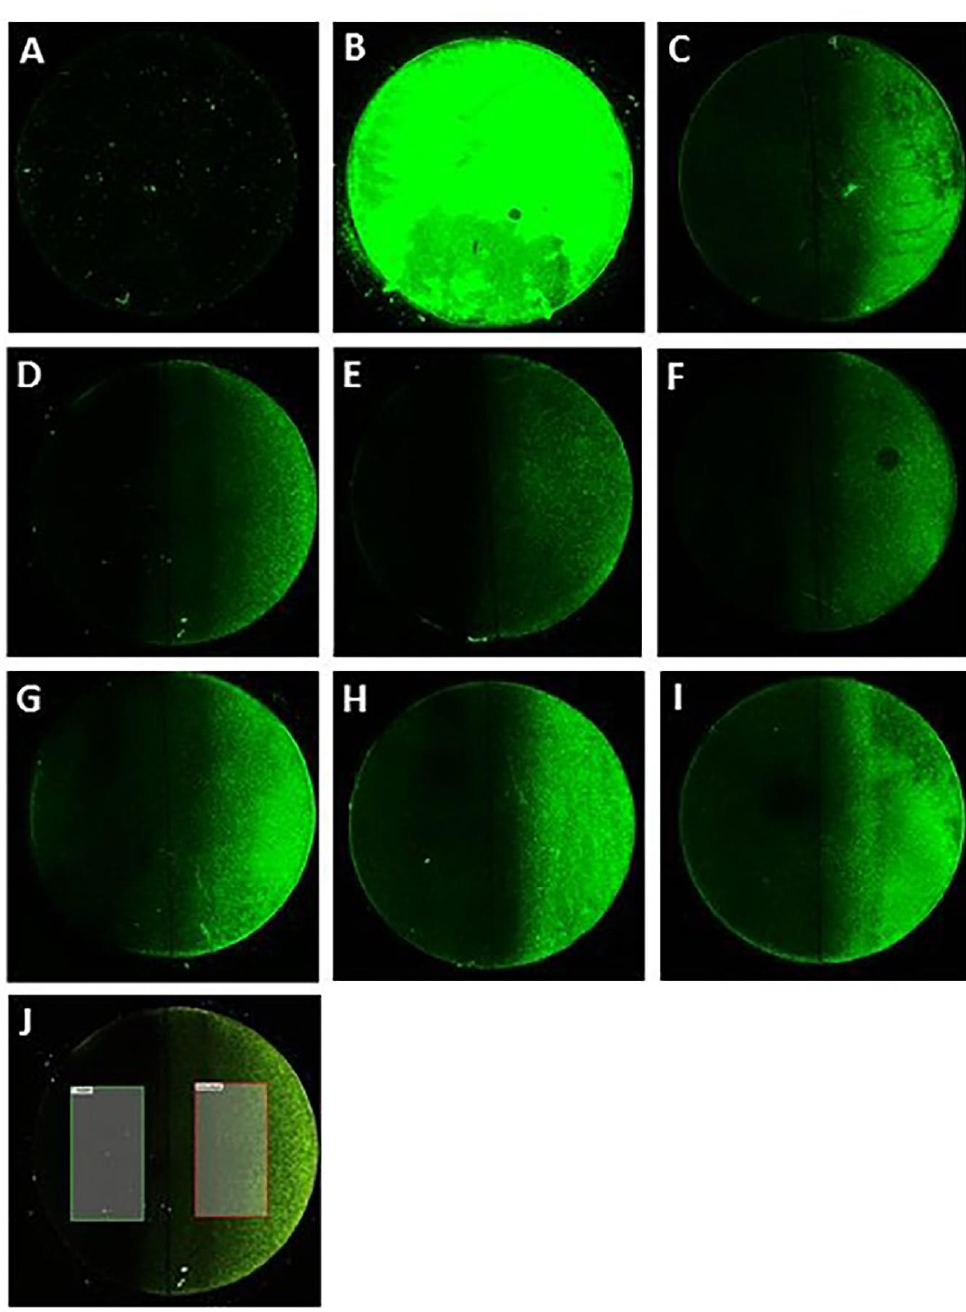
Figure 6. Autofluorescence of bacterial biofilm on MRS discs before and after treatment with air abrasive unit delivering different powders: ( A ) pristine disc; ( B ) contaminated untreated disc; ( C ) group 7; ( D ) group 1; ( E ) group 2; ( F ) group 6; ( G ) group 3; ( H ) group 4; ( I ) group 5; ( J ) group 1 with rectangles for fluorescence measurement.